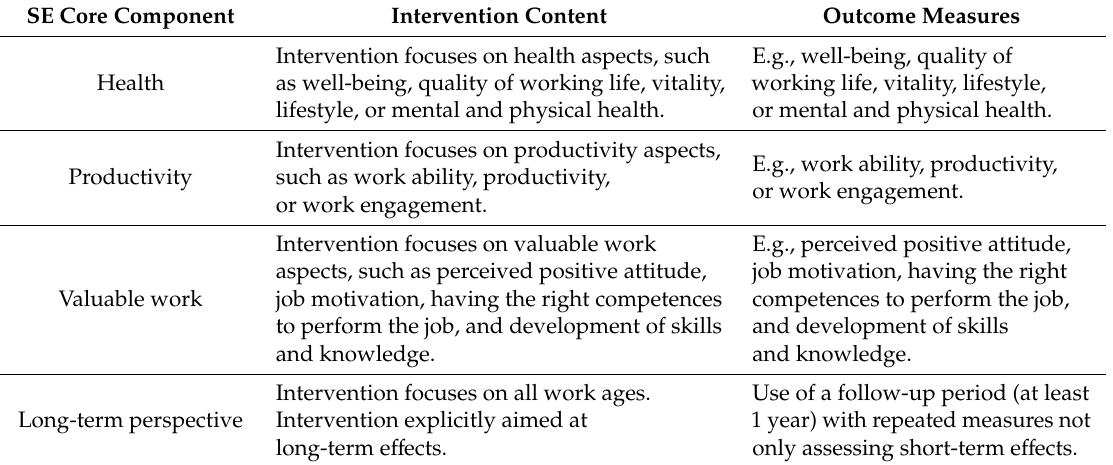
Table 1. Operationalization of sustainable employability (SE) core components in intervention content and outcome